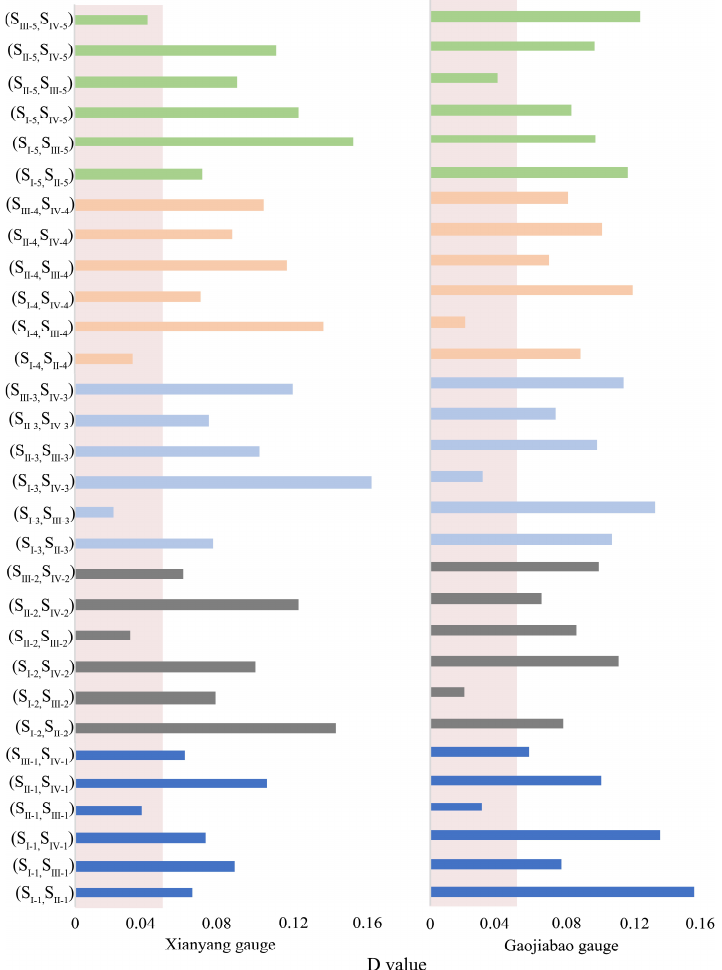
Figure 10. Kolmogorov–Smirnov (K-S) test results. S I-1 denotes the IMF1 decomposed from the first segment, S II-1 denotes the IMF1 decomposed from the second segment, and the red areas demonstrate confidence intervals of 0.05, by which the significant similar IMFs can be identified. Int. J. Environ. Res. Public Health 2019 , 16 , x FOR PEER REVIEW